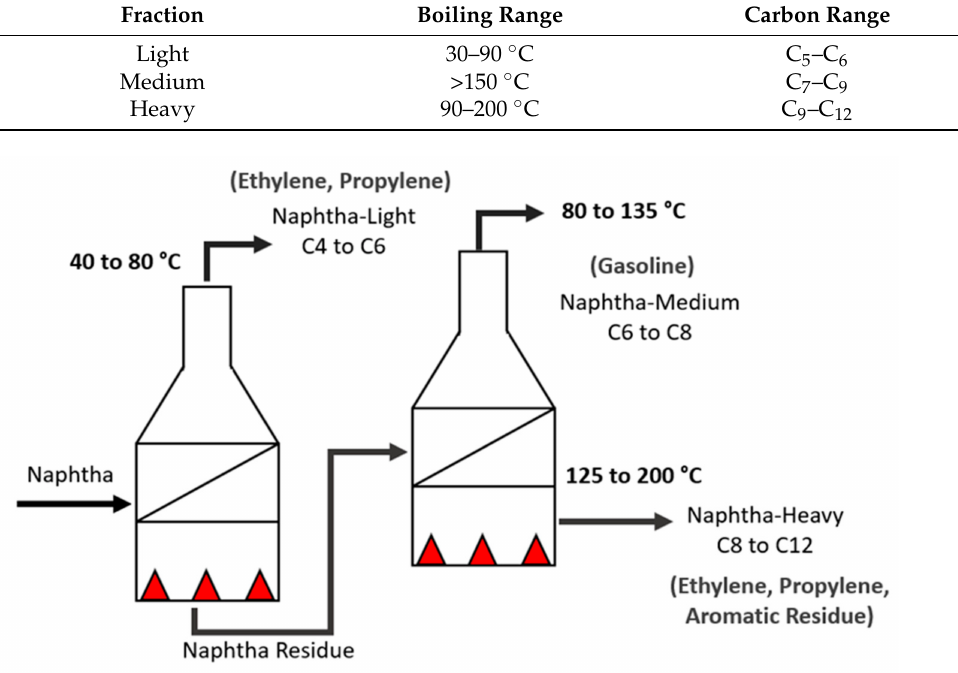
Table 2. Naphtha fractions.